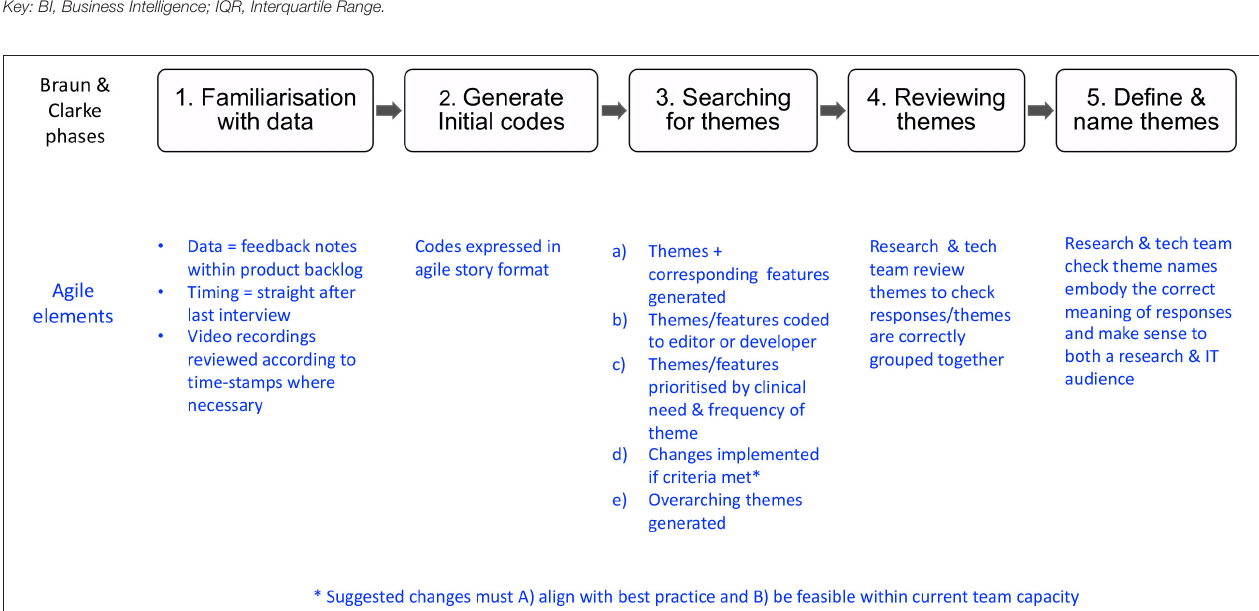
FIGURE 7 | Rapid Agile analysis (Adapted from Braun and Clarke